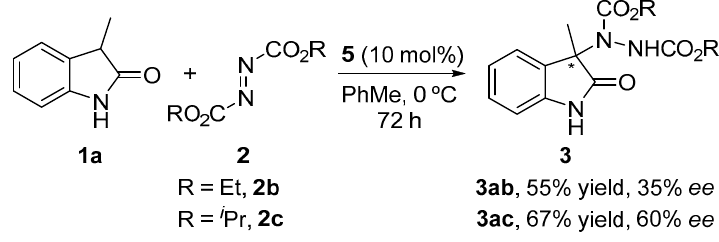
Figure 2. Benzimidazole-derived organocatalysts tested.